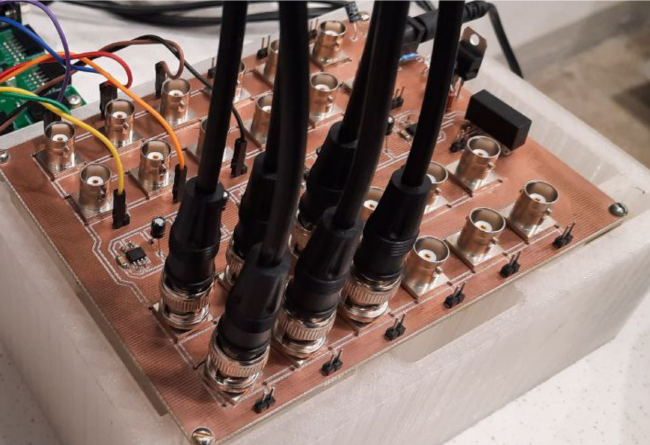
Figure 2. The two-layered level shifter board.